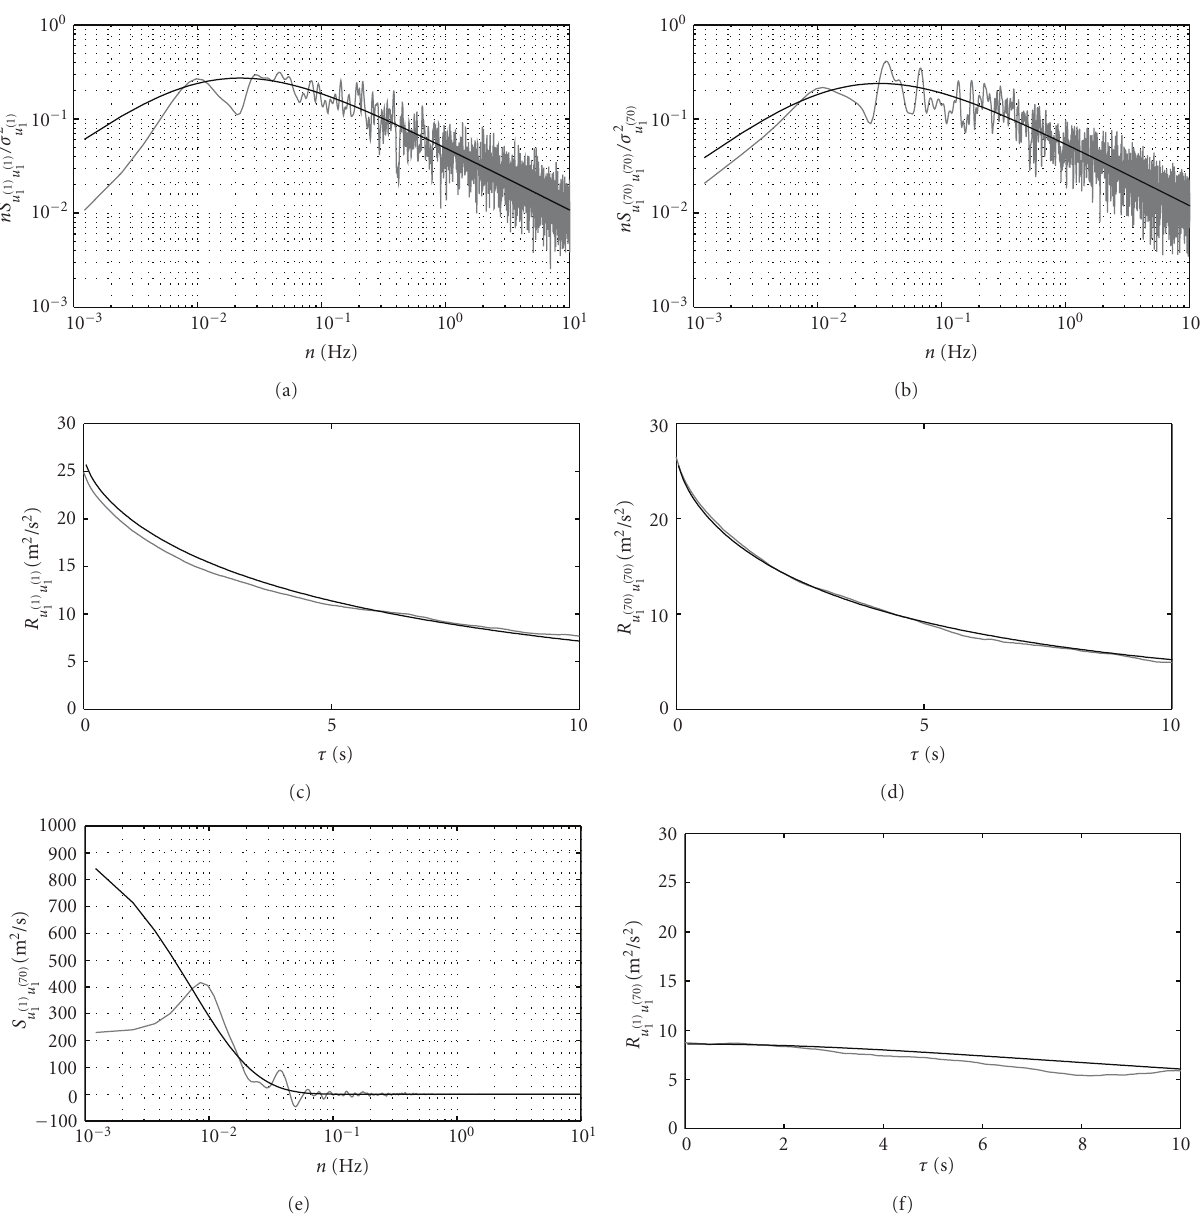
Figure 11: Example 2 using POD method (black lines denote target functions, gray lines denote numeric approximations): auto-spectra of along-wind velocities at points 1 and 70 (a), (b); corresponding autocorrelation functions (c), (d); cross-spectrum of along-wind velocities in points 1 and 70 (e); corresponding cross-correlation function